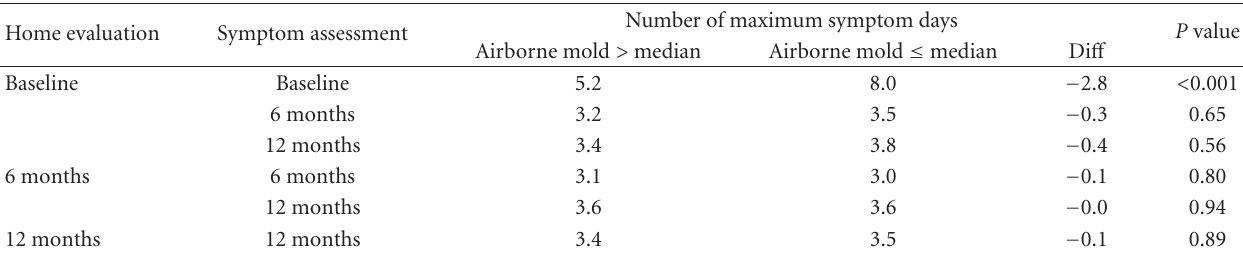
Table 5: Relationship between airborne mold levels and asthma morbidity by study